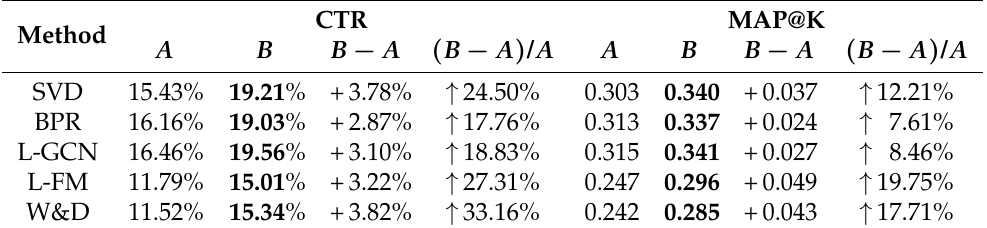
Table 4. The results of A/B experiments on the Amazon dataset.